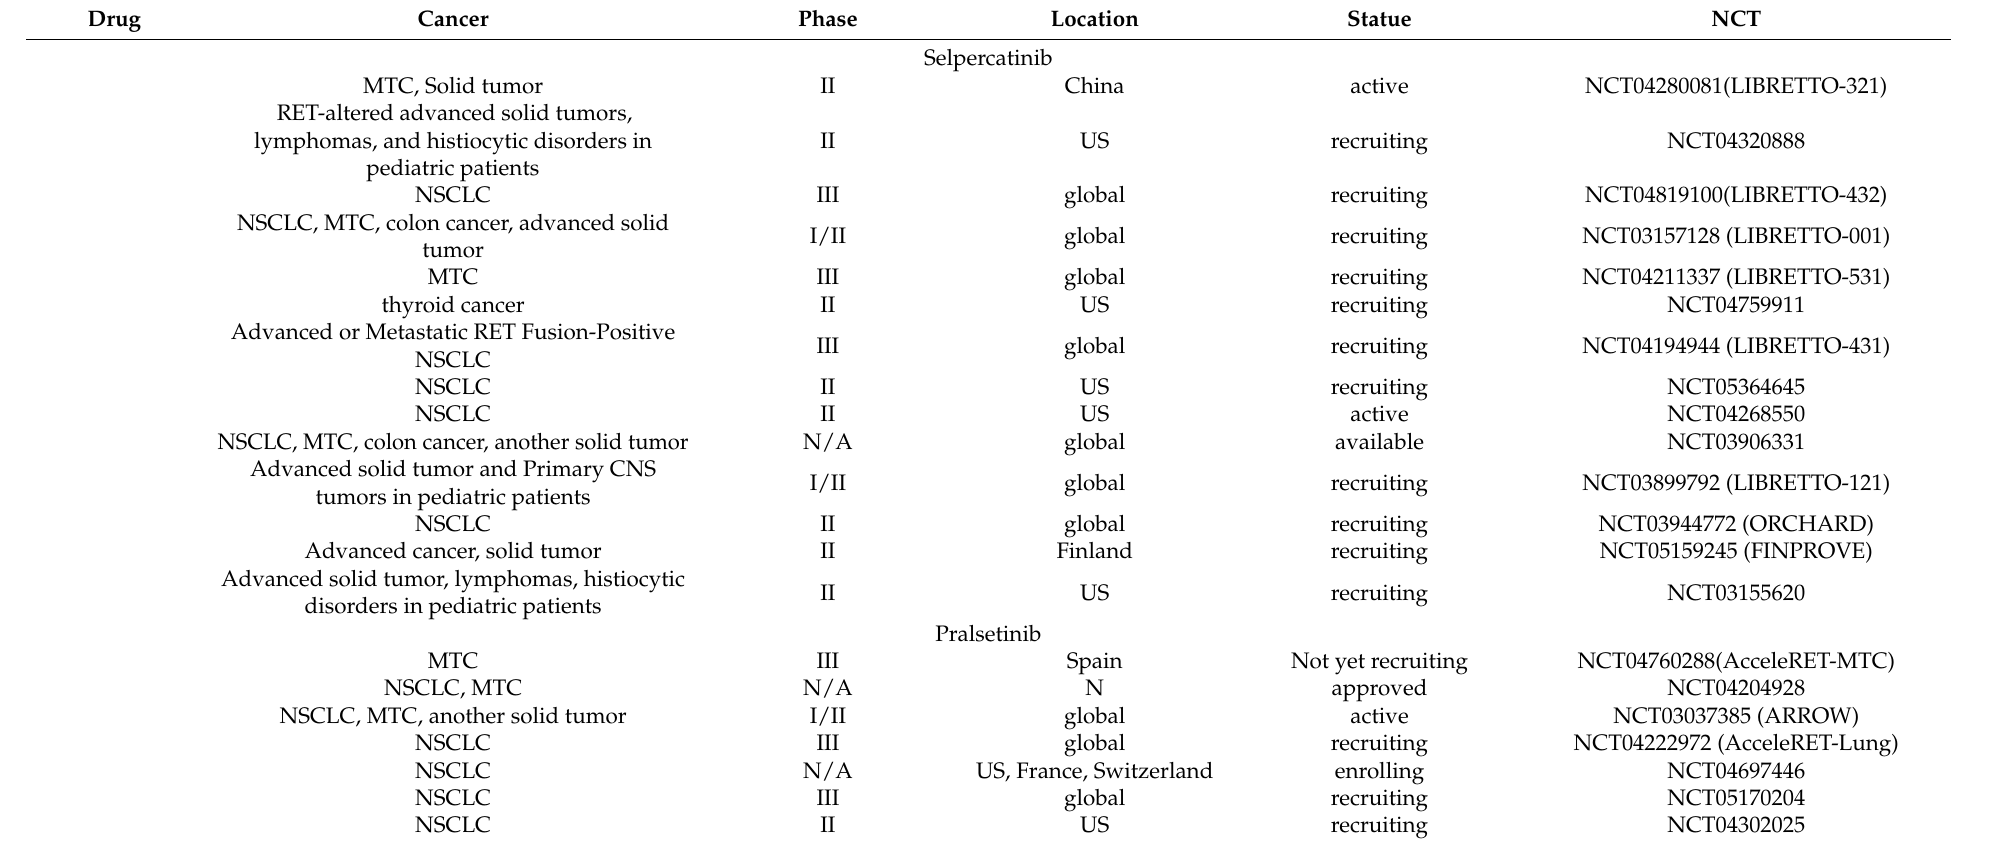
Table 1. Clinical trial of RET selective inhibitor for cancer. CNS, central nervous system; MTC, medullary thyroid carcinoma; NSCLC, non-small cell lung cancer; N/A, not applicable; NCT, National Clinical